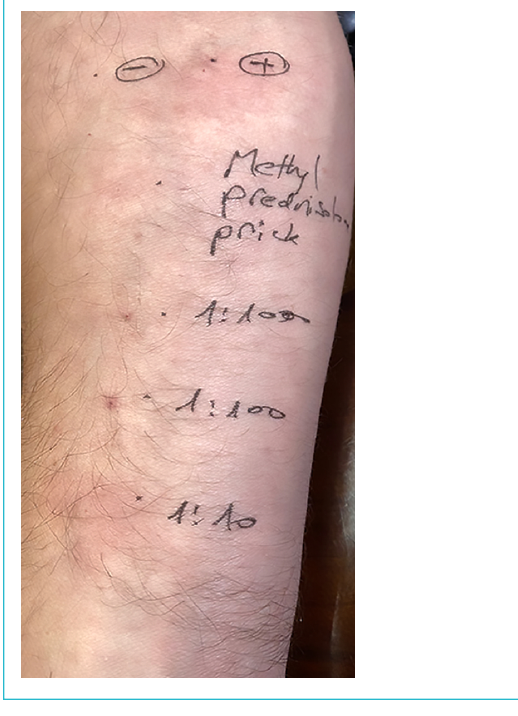
Figure 3: Positive intradermal test for methylprednisolone as part of evaluation of immediate hypersensitivity reaction. Positive and negative controls are included in the test.